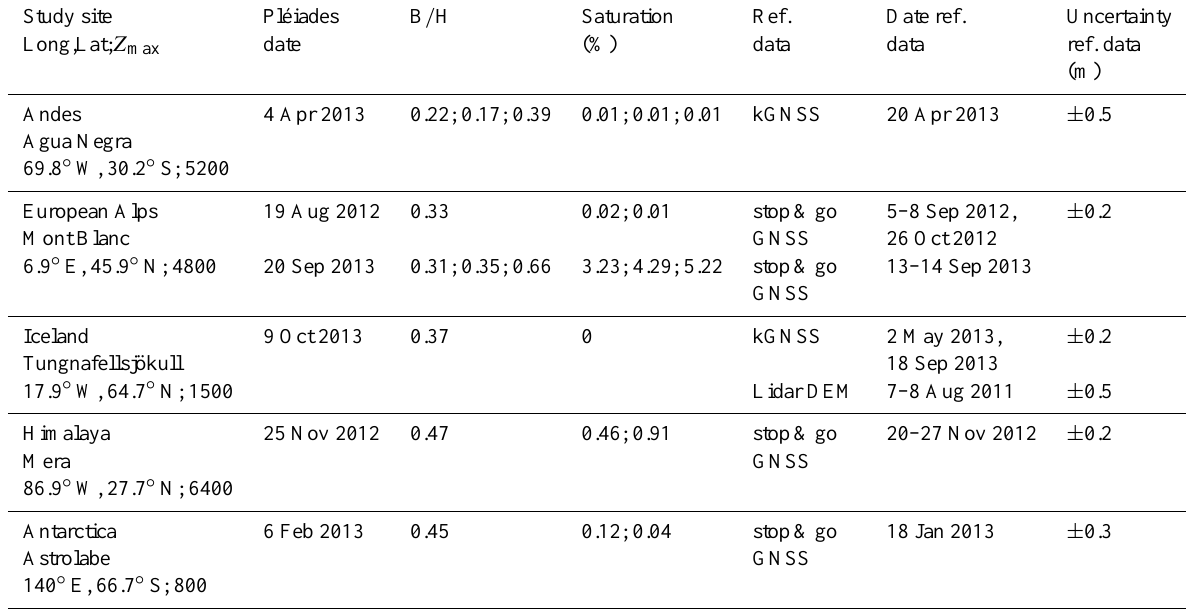
Table 1. Characteristics of the study sites and Pléiades images. For each site, the approximate geographic coordinates and maximum altitude ( Z max , ma.s.l.) are indicated. All images were acquired by Pléiades-1A, except a Pléiades-1B stereo pair over Tungnafellsjökull. The base-to- height ratio (B / H), the ratio of the distance between two successive positions of the satellite to its height above ground, is an indicator of the sensitivity to topography. A single B / H is indicated for stereo pairs, whereas three values for the front/nadir, nadir/back and front/back pairs are provided for tri-stereos. The percentage of saturation in the image is given for the front/back images for stereo pairs and front/nadir/back for tri-stereos. The reference (noted Ref.) altimetric data used to evaluate the Pléiades DEMs are kinematic global navigation satellite system (kGNSS), stop and go GNSS measurements and, for the Tungnafellsjökull Ice Cap only, a lidar DEM. Identification codes of the Pléiades images are not listed for the sake of